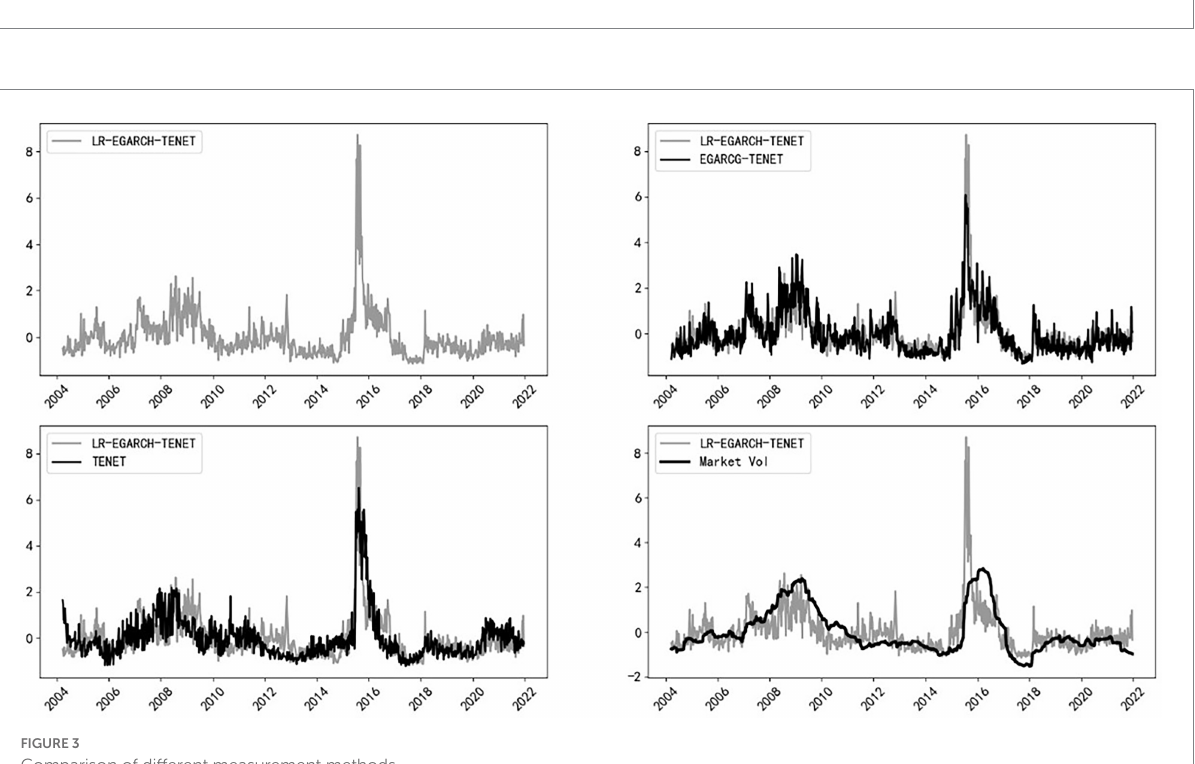
FIGURE 3 Comparison of different measurement